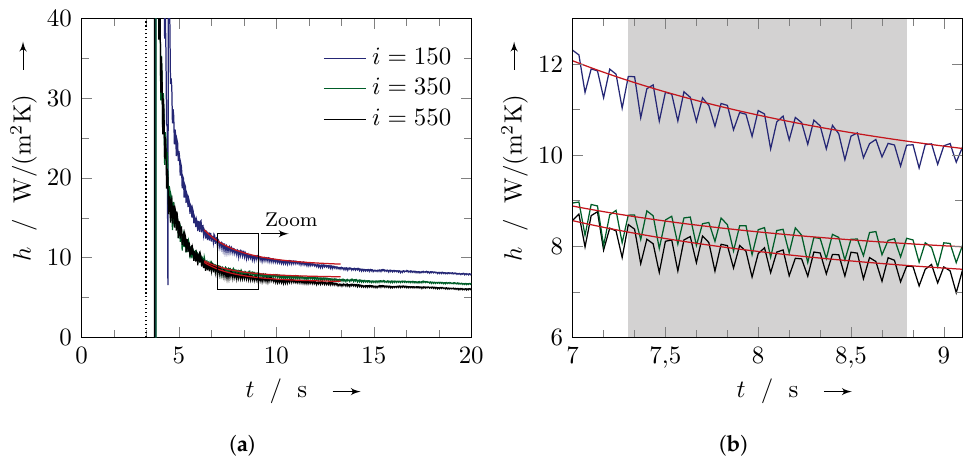
Figure 6. Transient results for the heat transfer coefficient due to natural convection including the modeled polynomial functions from Equation (10) (red lines): ( a ) Results for three pixel heights i ; ( b ) Zoom into the region of